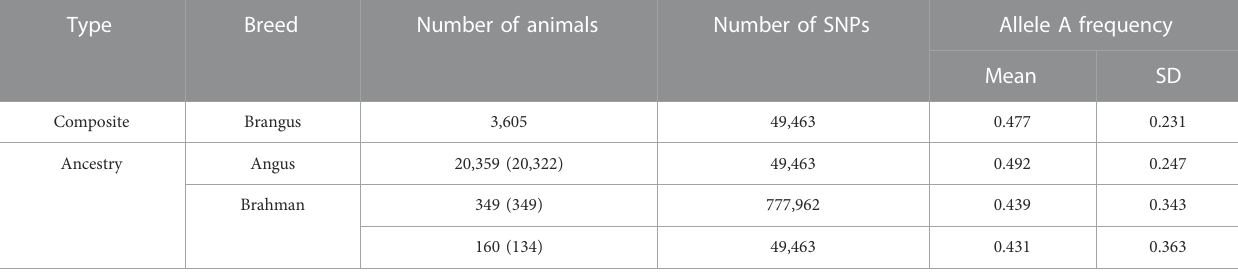
TABLE 1 Descriptive statistics of genotype data for Brangus and their ancestral breeds (Angus and Brahman) a